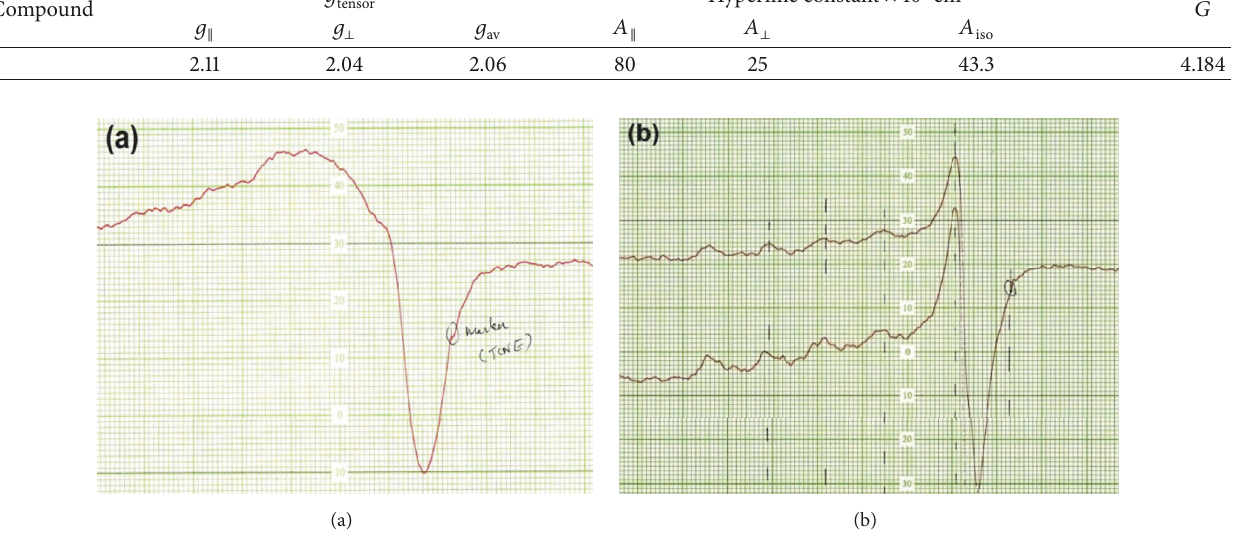
Figure 2: ESR spectra of complex 1 : (a) RT and (b) LNT.